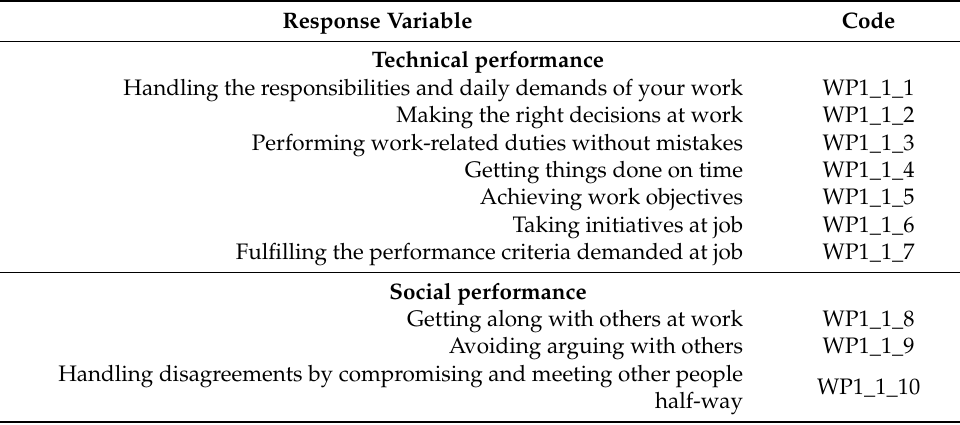
Table 1. Response variables (technical and social